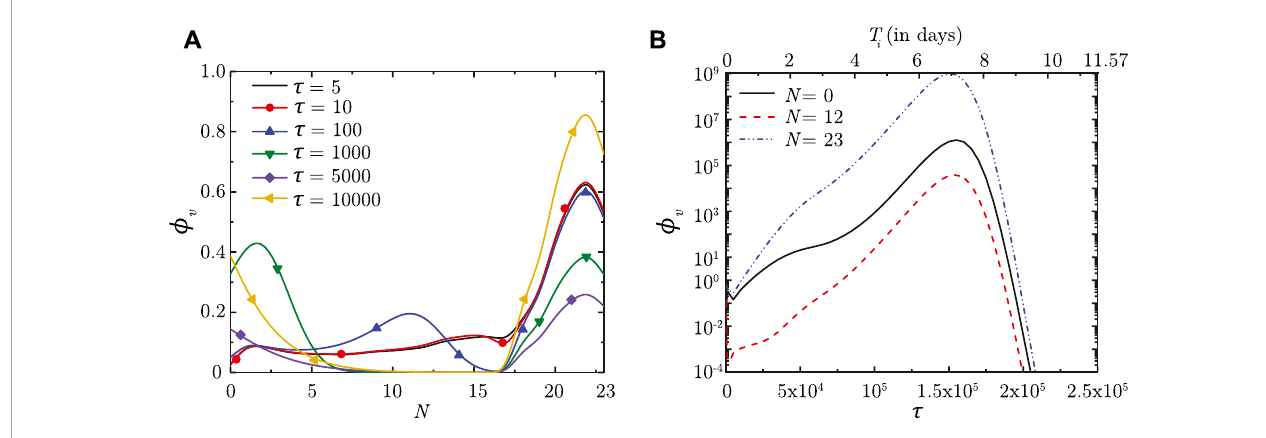
FIGURE 2 (A) Dimensionless virus concentration in mucus ( ϕ v ) within the LRT at different dimensionless time instances ( τ ) post onset of infection and (B) Temporal change in ϕ v at different spatial locations within the LRT ( N = 0 , 12 , 23; N represents the lung generation number). The results in (B) are shown with respect to a dimensionless time ( τ ) as well as a dimensional time ( T i ) post infection onset. The breathing time period ( T b = 4s) is considered for obtaining the dimensional time (see Eq. 7 ). All results are shown considering the baseline parameter values (see Table 1